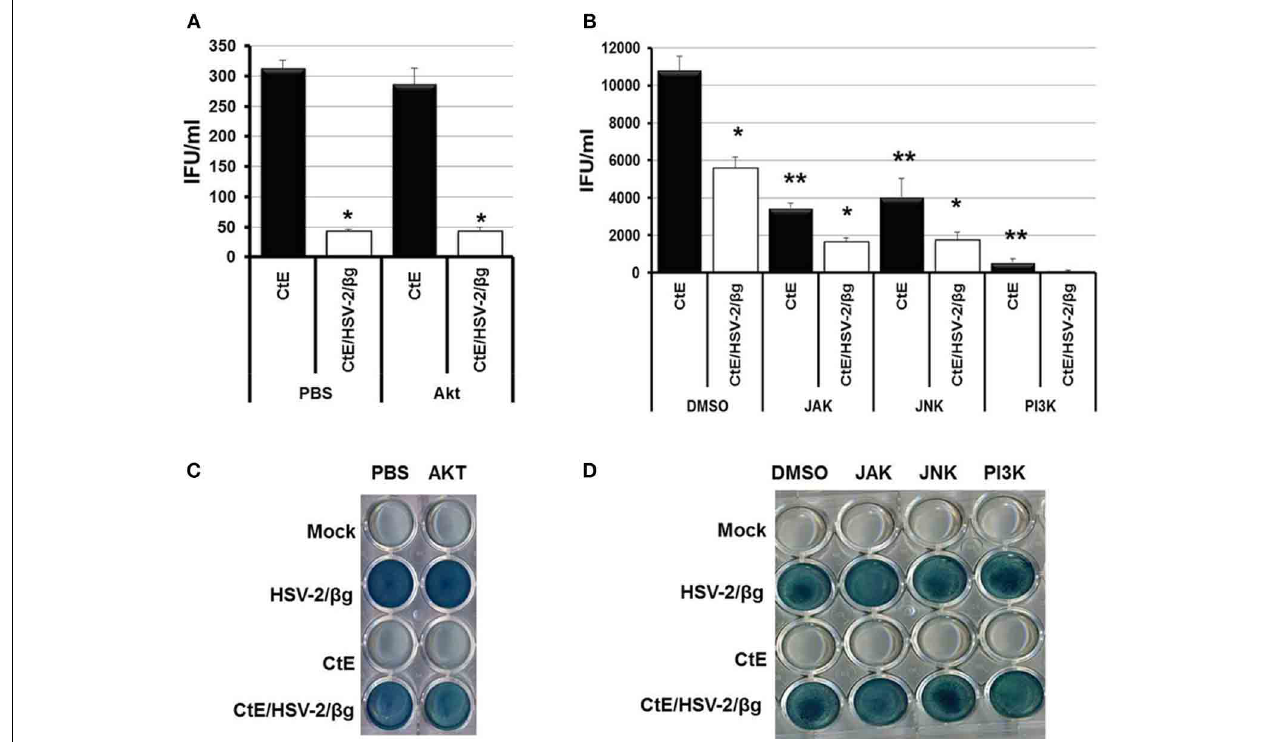
FIGURE 2 | Inhibition of Akt, JAK, JNK, or PI3K during CtE/HSV-2/ β g co-infection does not restore EB production. Replicate HeLa monolayers were mock-, CtE-, HSV-2/ β g-, and CtE/HSV-2/ β g -infected. (A) PBS or an Akt inhibitor was added to the culture medium 12h post CtE infection and remained in the cultures throughout HSV infection. (B) DMSO or a JAK, JNK, or PI3K inhibitor was added to the culture medium 23h post CtE infection and remained in the cultures throughout HSV infection. Cultures were